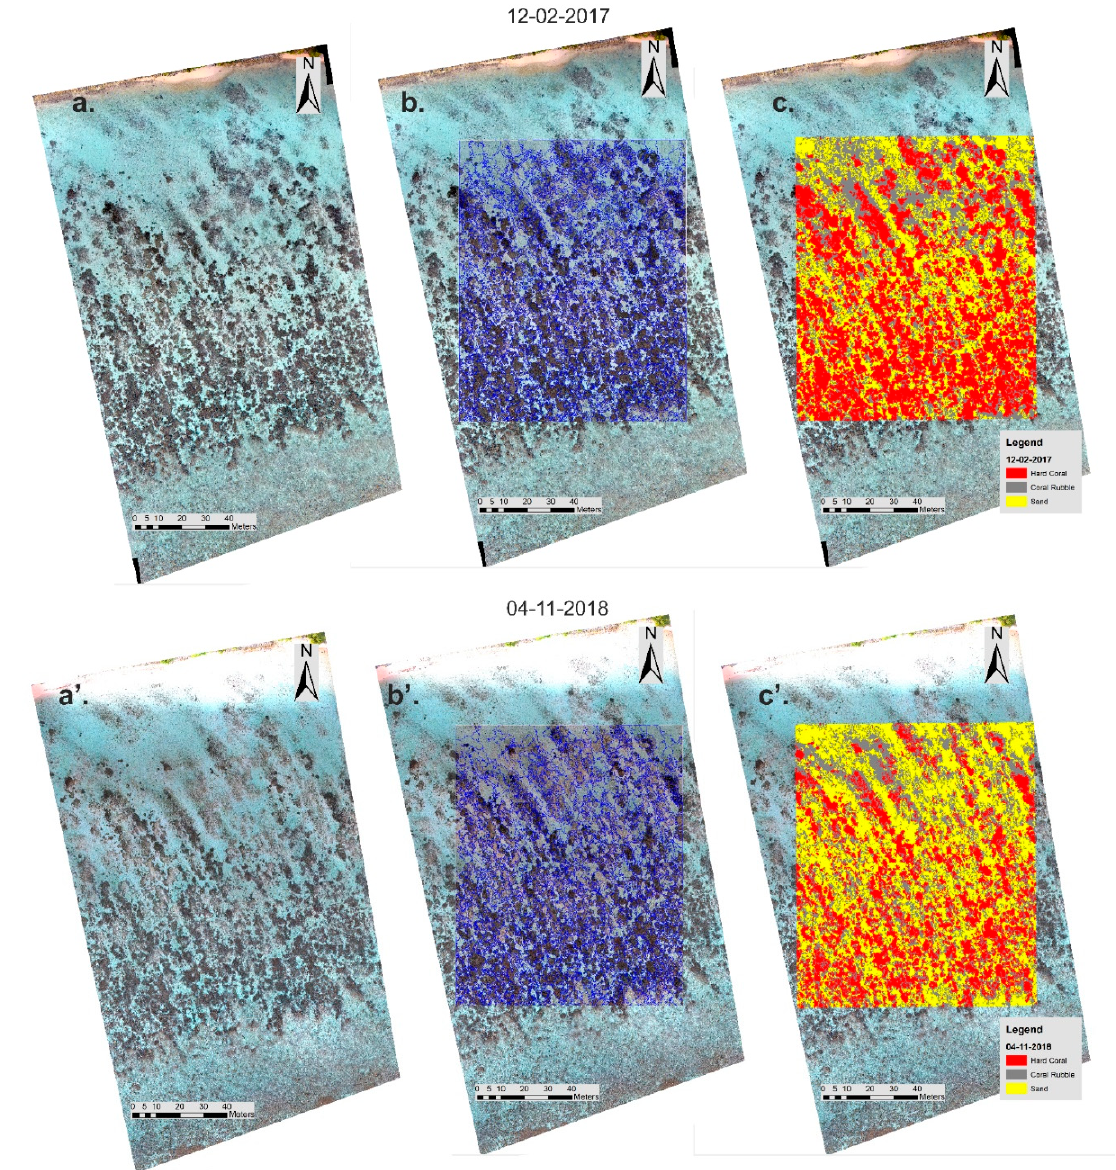
Figure 4. Examples of results obtained from the application of the OBIA workflow in Area 2. High-resolution orthomosaics of Area 2 ( a,a’ ) over time. Image segmentation output ( b,b’ ) and classification of substrate type ( c,c’ ) in February 2017 and November 2018.